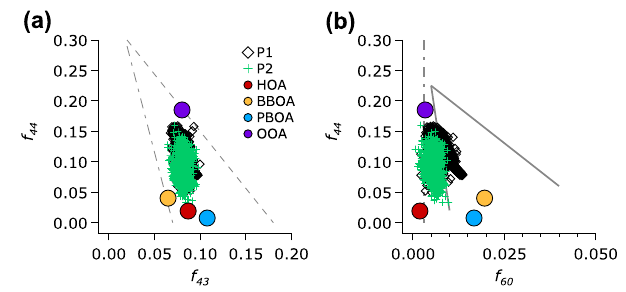
Figure 7. (a) Scatter plot of f 44 (mass fraction of m/z 44 to the total OA) as a function of f 43 (mass fraction of m/z 43) of the OA and the factors resolved by the ME-2 analysis. The grey dashed lines depicts the triangle plot (Ng et al., 2010), which is a guide to show aging of the total OA (classified into the P1 and P2 periods) and the OA factors. (b) Scatter plot of f 44 as a function of f 60 of the total OA and the OA factors is plotted over the conceptual space for biomass burning aerosol aging (solid grey lines) and the nominal background/urban value of f 60 at 0.3% (grey dashed and dotted line; Cubison et al.,